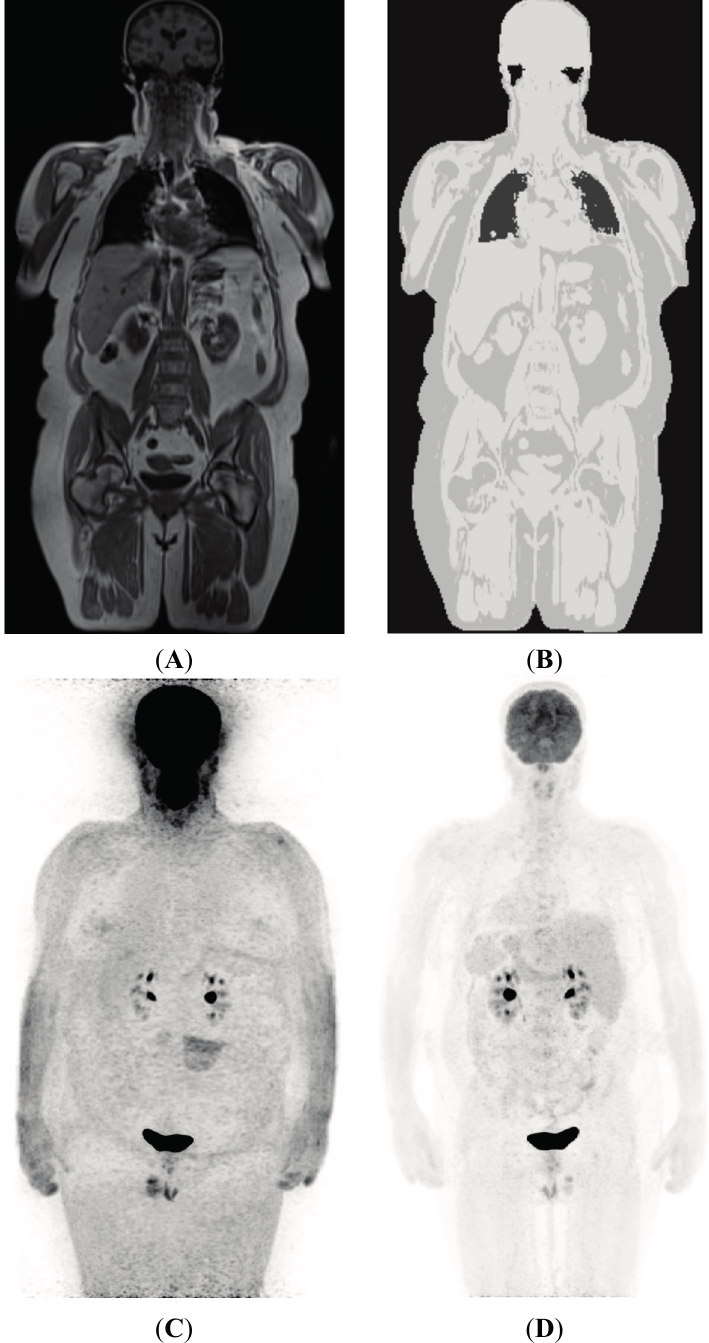
Figure 1. ( A ) Coronal plane image from the Dixon VIBE sequence used to generate a MR AC map; ( B ) shows attenuation map generated from ( A ). Note four gray levels separating air, lung, fat, and soft-tissue. Also note that while bone marrow appears similar to fat elsewhere, bone cortex and overlying muscles have been assigned similar attenuation values. Reliable separation of bone in AC maps is an area of active research; ( C ) A non-corrected 18 F-FDG PET image, showing non-uniform tracer distribution with spuriously higher uptake in peripheral tissues due to greater attenuation of emission photons from deeper structure; ( D ) AC-corrected image after applying MRI-based attenuation map shown in ( B